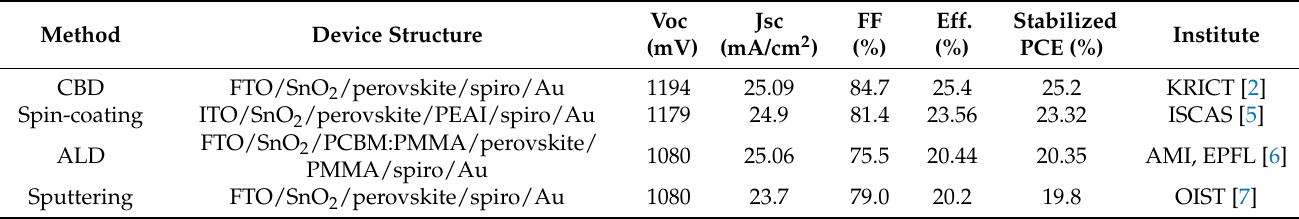
Table 1. Various reported methods of normal (n-i-p) type single-junction perovskite solar cell (PSC) fabrication, using tin oxide (SnO 2 ) electron transport layers (ETLs).